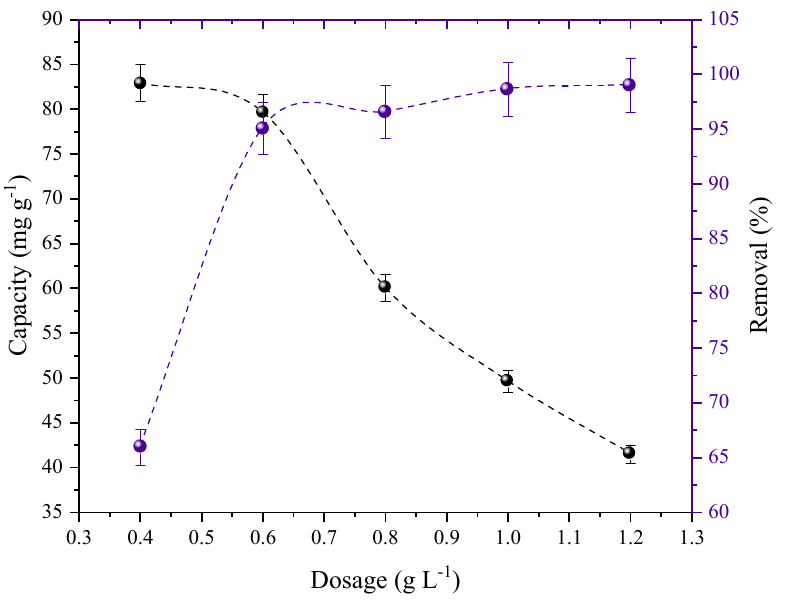
Figure 6. The effects of the AC dosage for the removal and adsorption of 2,4–D (C0 = 50 mg L − 1 ; T = 298 K; V = 50 mL; natural pH of the solution; stirring rate = 180 rpm).